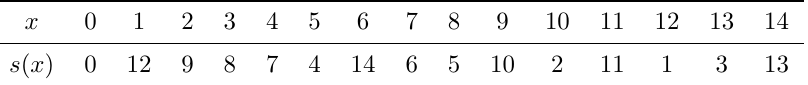
Table 1: The look up table of the permutation 𝑠 of Z / 15 Z